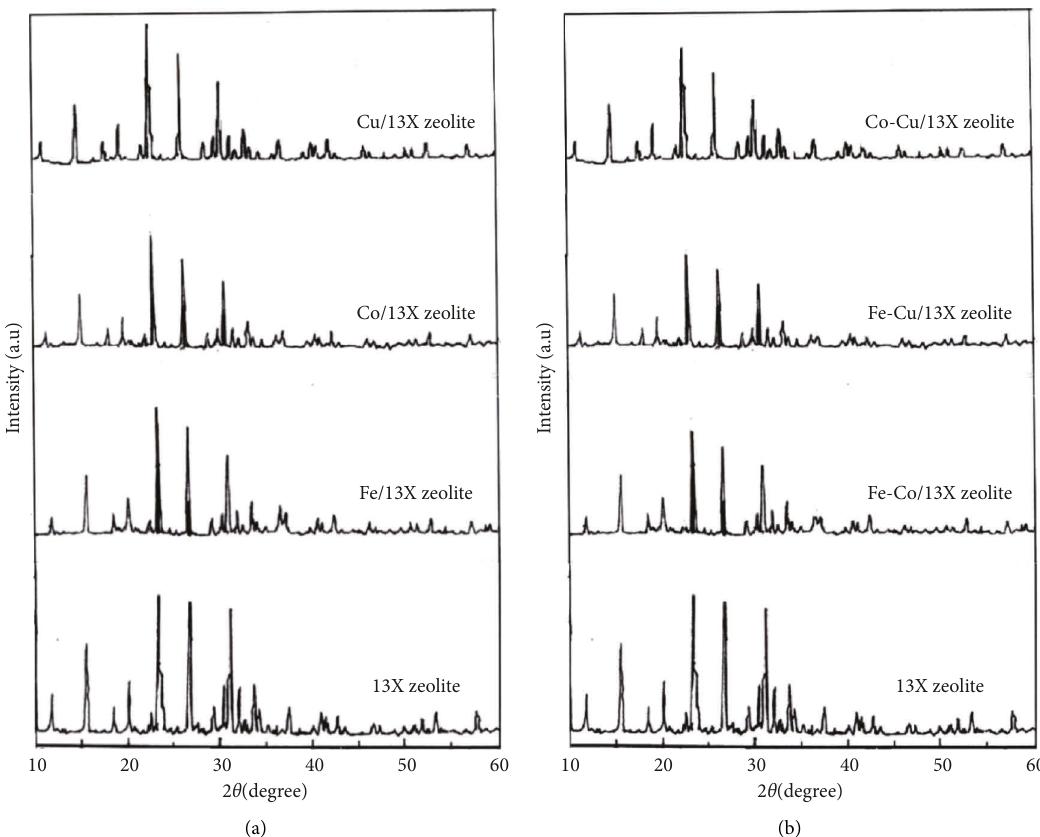
Figure 5: XRD patterns of; (a) 13X zeolite and monometal/13X zeolite catalysts and (b) 13X zeolite and bimetal/13X zeolite